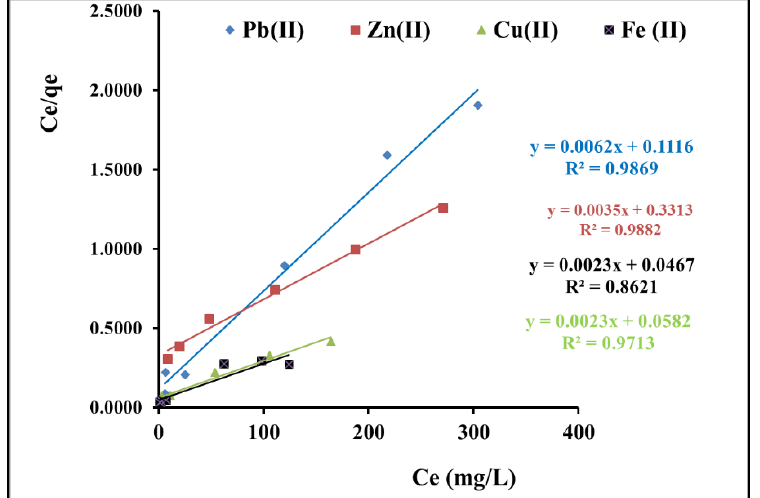
Figure 6. Langmuir adsorption isotherms for the adsorption of Pb(II), Zn(II), Cu(II), and Fe(II) onto RC-MWS.